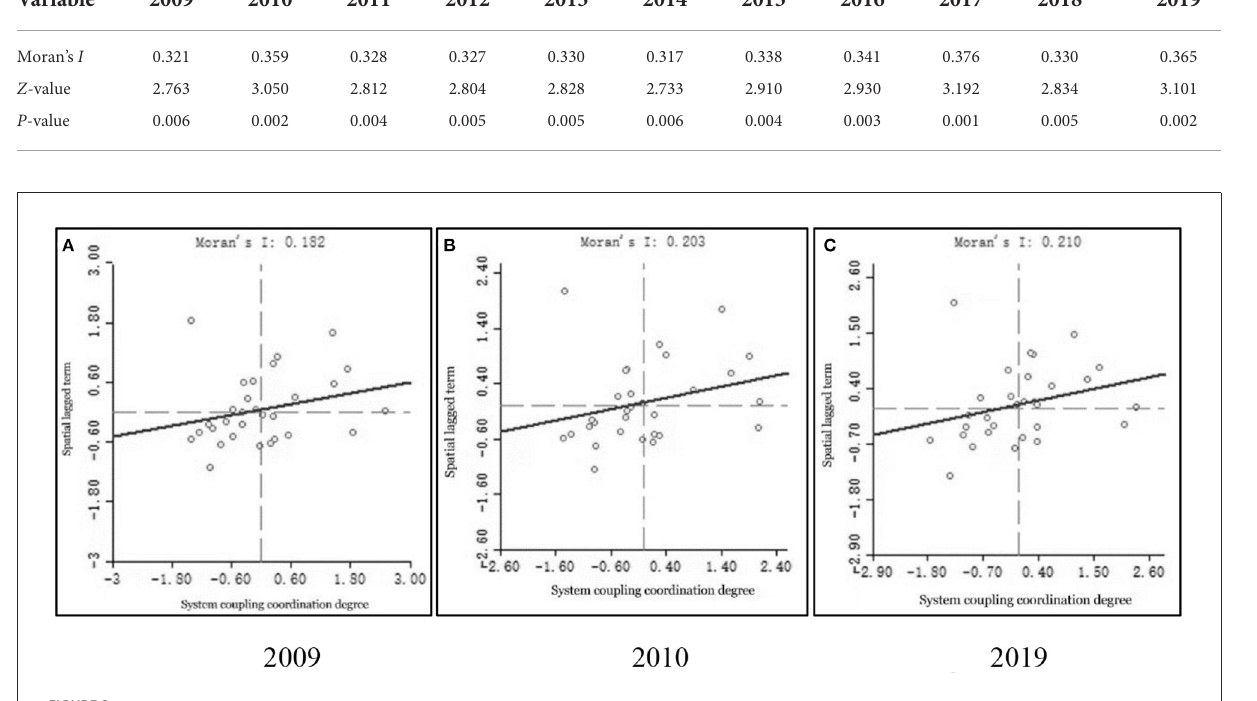
FIGURE8 (A–C) Moran scatter plot of coupling coordination degree in 2009, 2010, and